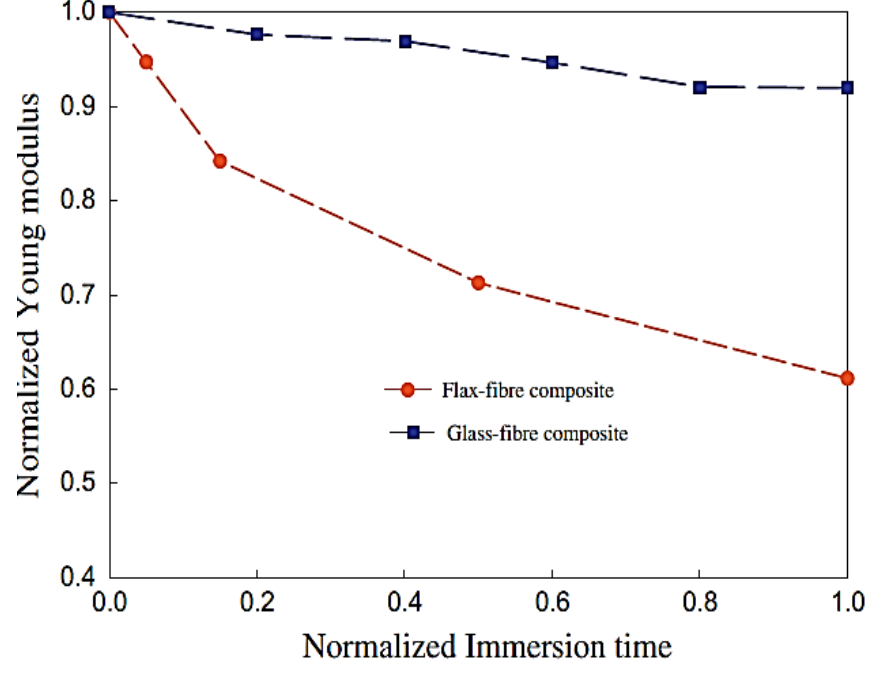
Figure 8. Normalised Young’s modulus (modulus/modulus at time = 0) versus normalised immersion time (test time/saturation time). Adapted with permission from [70]. Copyright 2013 by Elsevier.